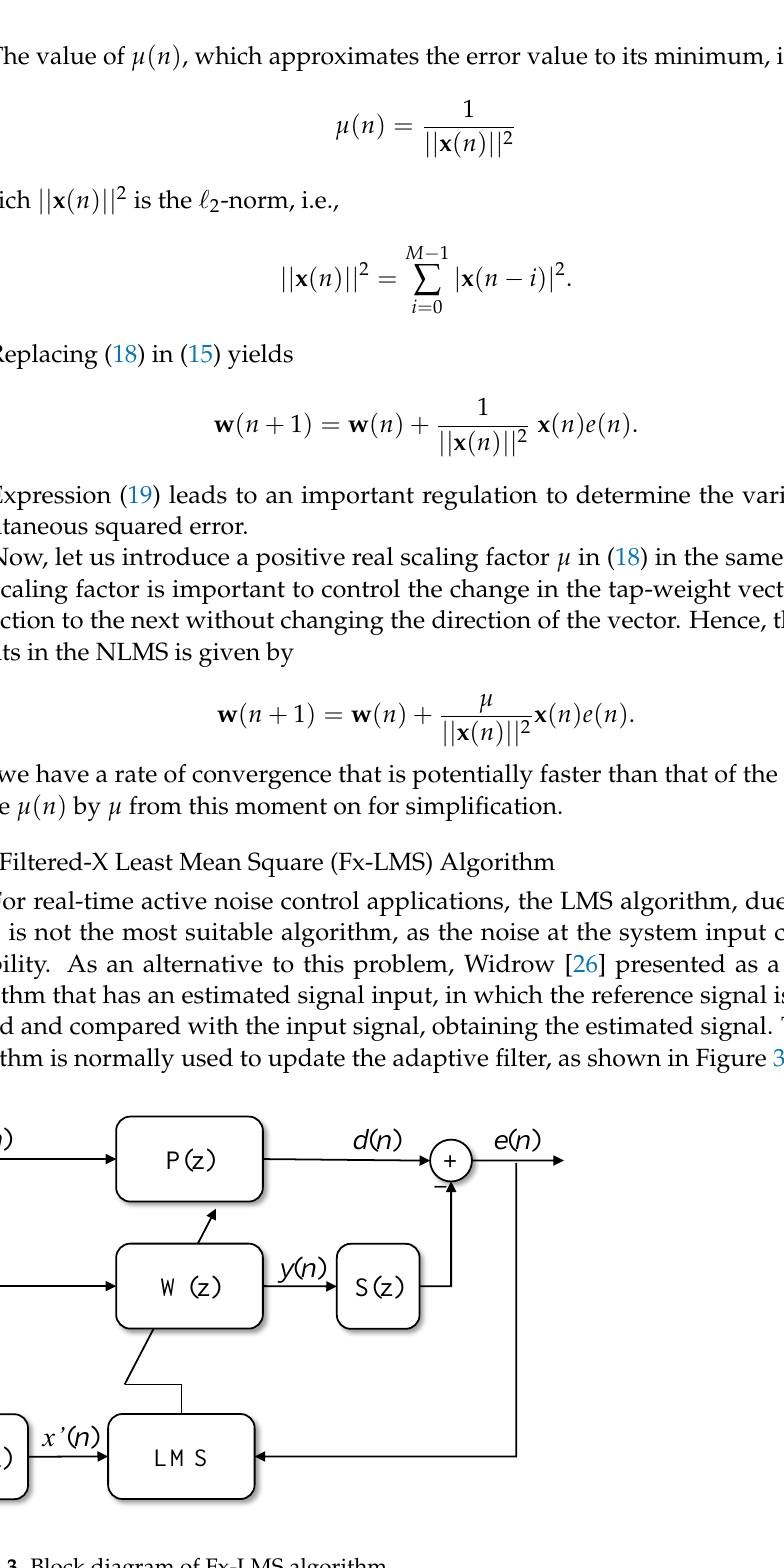
Figure 3. Block diagram of Fx-LMS